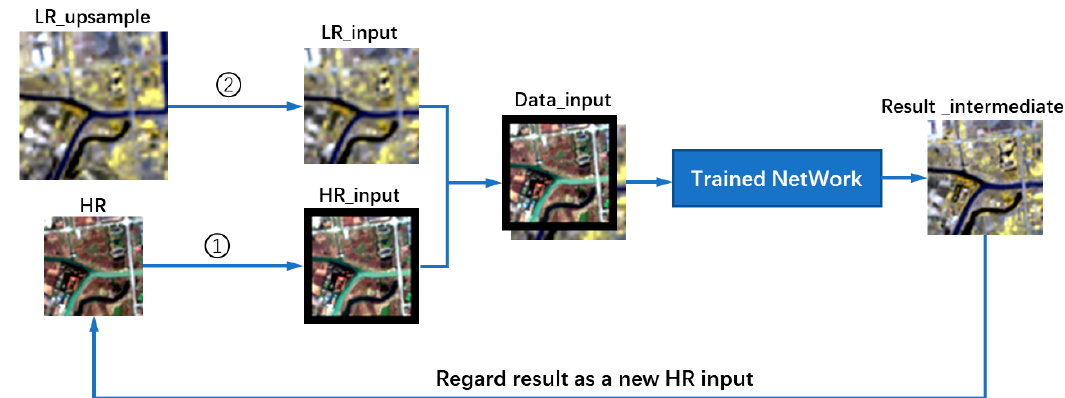
Figure 3. The process of the recurrent expanding strategy. Step 1: Expand the high spatial resolution (HR) data by several pixels assigned to 0. Step 2: Crop the low spatial resolution (LR)_upsample data to the same size and same coverage as the HR_input.